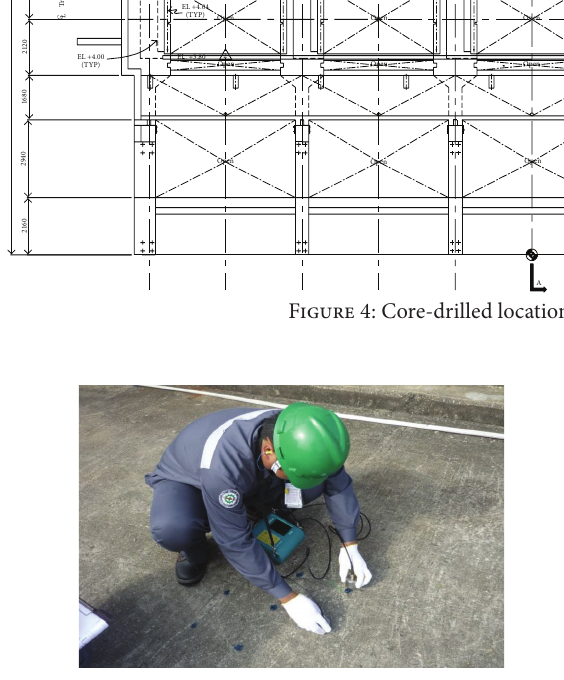
Figure 5: UPV test at train A/B. Figure 6: Hammer test at train